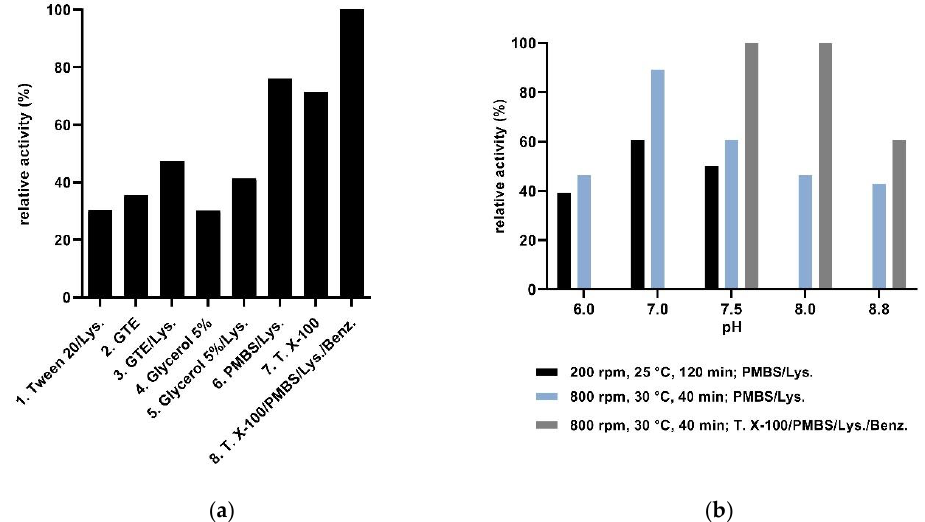
Figure 3. Assay optimizations monitoring the relative activity of the di ff erent cell lysates of I460V- Pc PAL, in the ammonia elimination reaction of p -MeO-Phe. The following lysis bu ff ers have been employed: ( a ) 1. Tween 20 bu ff er (50 mM NaH 2 PO 4 · 2H 2 O, 300 mM NaCl, 10 mM imidazole, 0.07 mM lysozyme, 400 U / mL DNAse I. 1% Tween20 pH 8), 2. GTE bu ff er (50 mM glucose, 10 mM EDTA, 25 mM Tris.HCl, pH 8), 3. GTE / Lys. bu ff er (50 mM glucose, 10 mM EDTA, 0.07 mM lysozyme, 25 mM Tris.HCl, pH 8), 4. 5% glycerol bu ff er (5 % glycerol, 100 mM NaCl, 1 mM DTT, 50 mM Tris.HCl, pH 7,5), 5. 5% glycerol / Lys. bu ff er (5 % glycerol, 100 mM NaCl, 1 mM DTT, 0.07 mM lysozyme, 50 mM Tris.HCl, pH 7,5), 6. PMBS / Lys. bu ff er (0.36 mM PMBS, 0.07 mM lysozyme, 50 mM NaCl, 20 mM Tris.HCl, pH 8.8), 7. Triton X-100 bu ff er (2% Triton X-100, 50 mM NaCl, 20 mM Tris.HCl, pH 8.8), 8. Triton X-100 / PMBS / Lys. / Benz. bu ff er (2% Triton X-100, 0.36 mM PMBS, 0.07 mM lysozyme, 25 U / mL benzonase, 50 mM NaCl, 20 mM Tris.HCl, pH 8.8). ( b ) Optimizations using the two component PMBS / Lys. bu ff er and the four-component Triton X-100 / PMBS / Lys. / Benz. bu ff er systems with di ff erent pHs and / or lysis conditions. Abbreviations: Lys., PMBS, T. X-100 and Benz. denote for lysozyme, polymyxin B sulphate, Triton X-100 and benzonase,